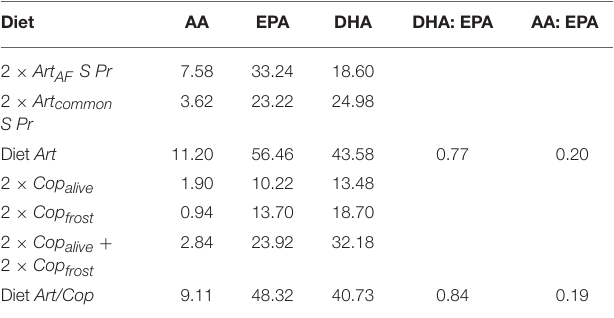
TABLE 4 | Estimates of the relative HUFA percentages and ratios in the diets Art and Art / Cop . Diet AA